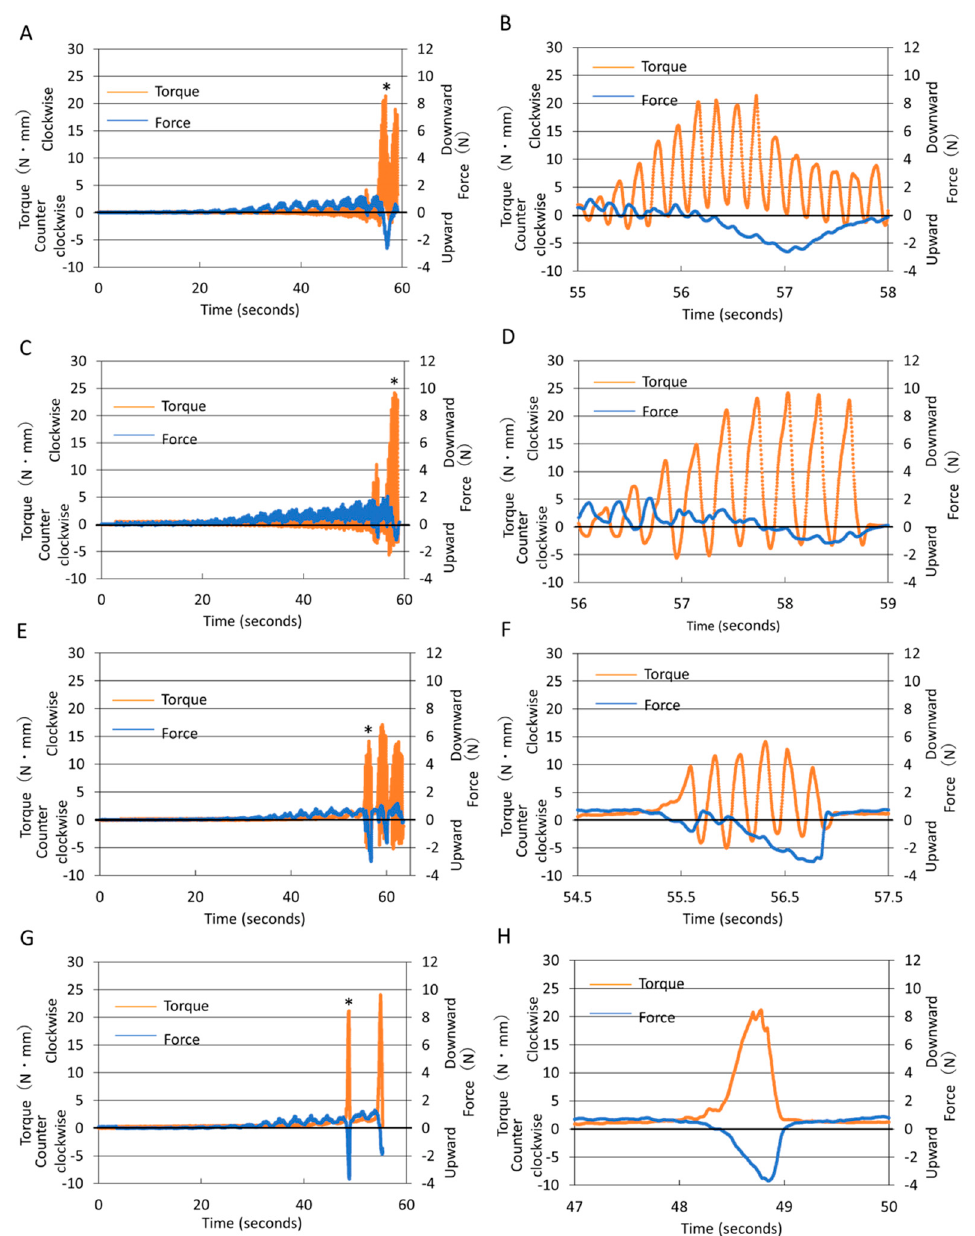
Figure 2. Representative recordings of torque and force values during instrumentation with R150/30 ( A , B ), R240/120 ( C , D ), OTR ( E , F ), and CR ( G , H ). ( B , D , F , H ) Time-expanded diagrams near the maximum clockwise torque peak (*) in ( A , C , E , G ). Positive and negative force and torque values refer to upward and downward force and clockwise and counterclockwise torque, respectively. Labels on the x-axis indicate time (seconds) from the initiation of instrumentation.